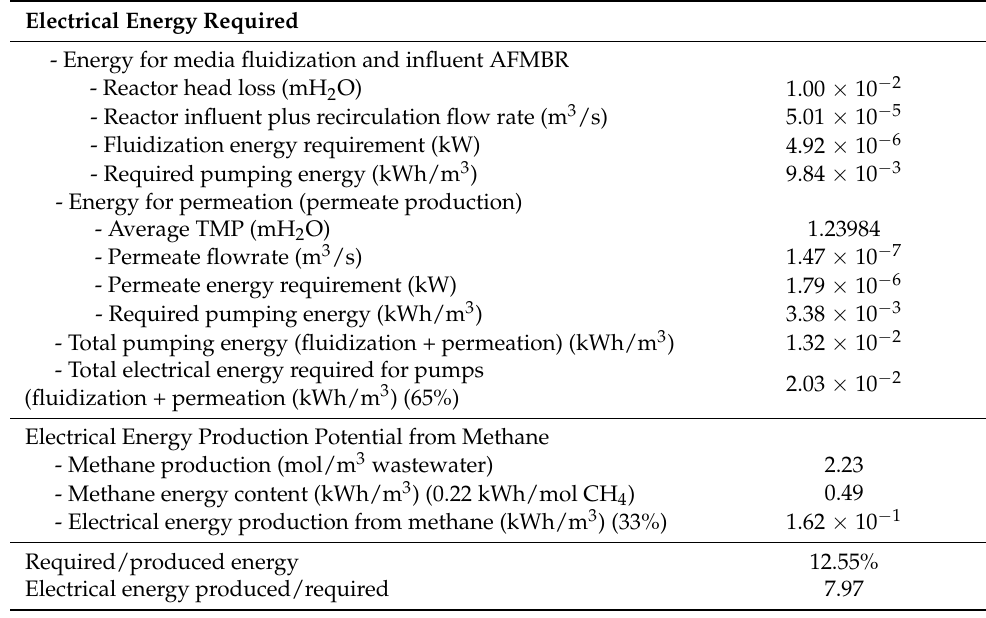
Table 5. Energy balance for electrical energy requirements and potential production with